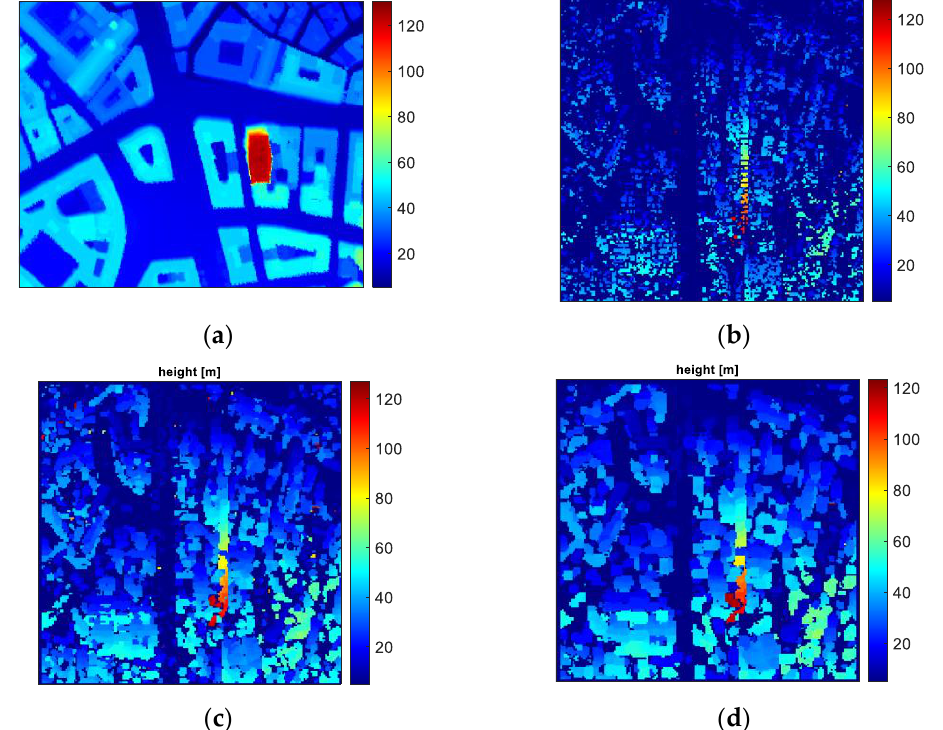
Figure 8. Jolly Hotel test site: ( a ) LiDAR height map; ( b ) Single-look GLRT height map; ( c ) MGLRT height map obtained using a 3 × 3 patch; ( d ) MGLRT height map obtained using a 5 × 5 patch.